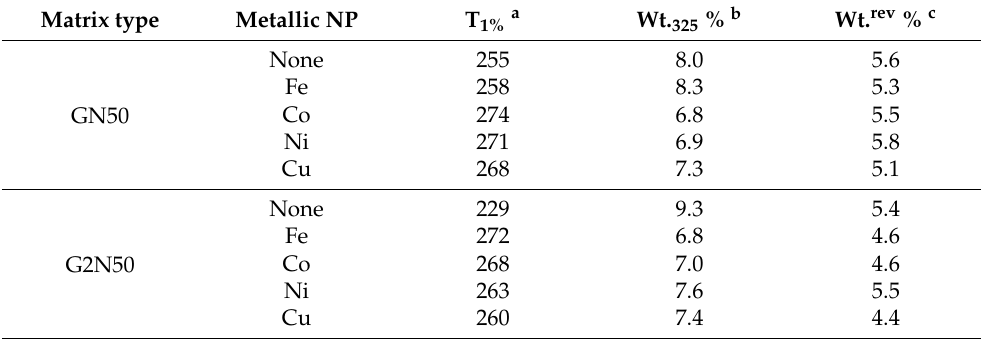
Molecules 2022 , 27 , x FOR PEER REVIEW